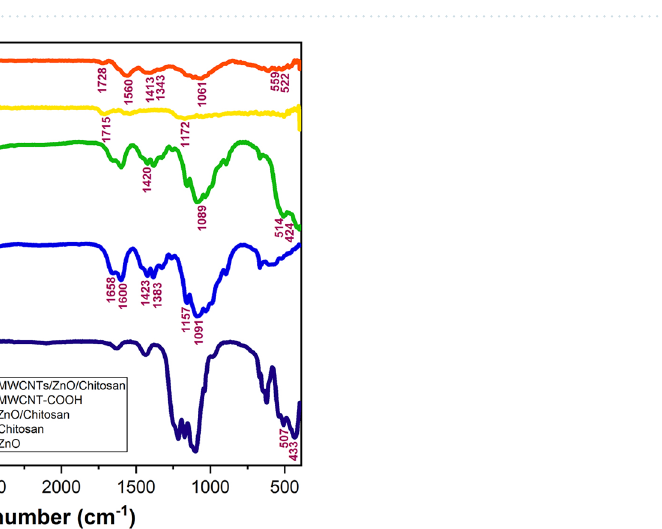
Figure 4. ( a ) TEM images of MWCNTs/ZnO/Chitosan nanocomposite, ( b ) AFM 3D image of MWCNTs/ZnO/ Chitosan nanocomposite.